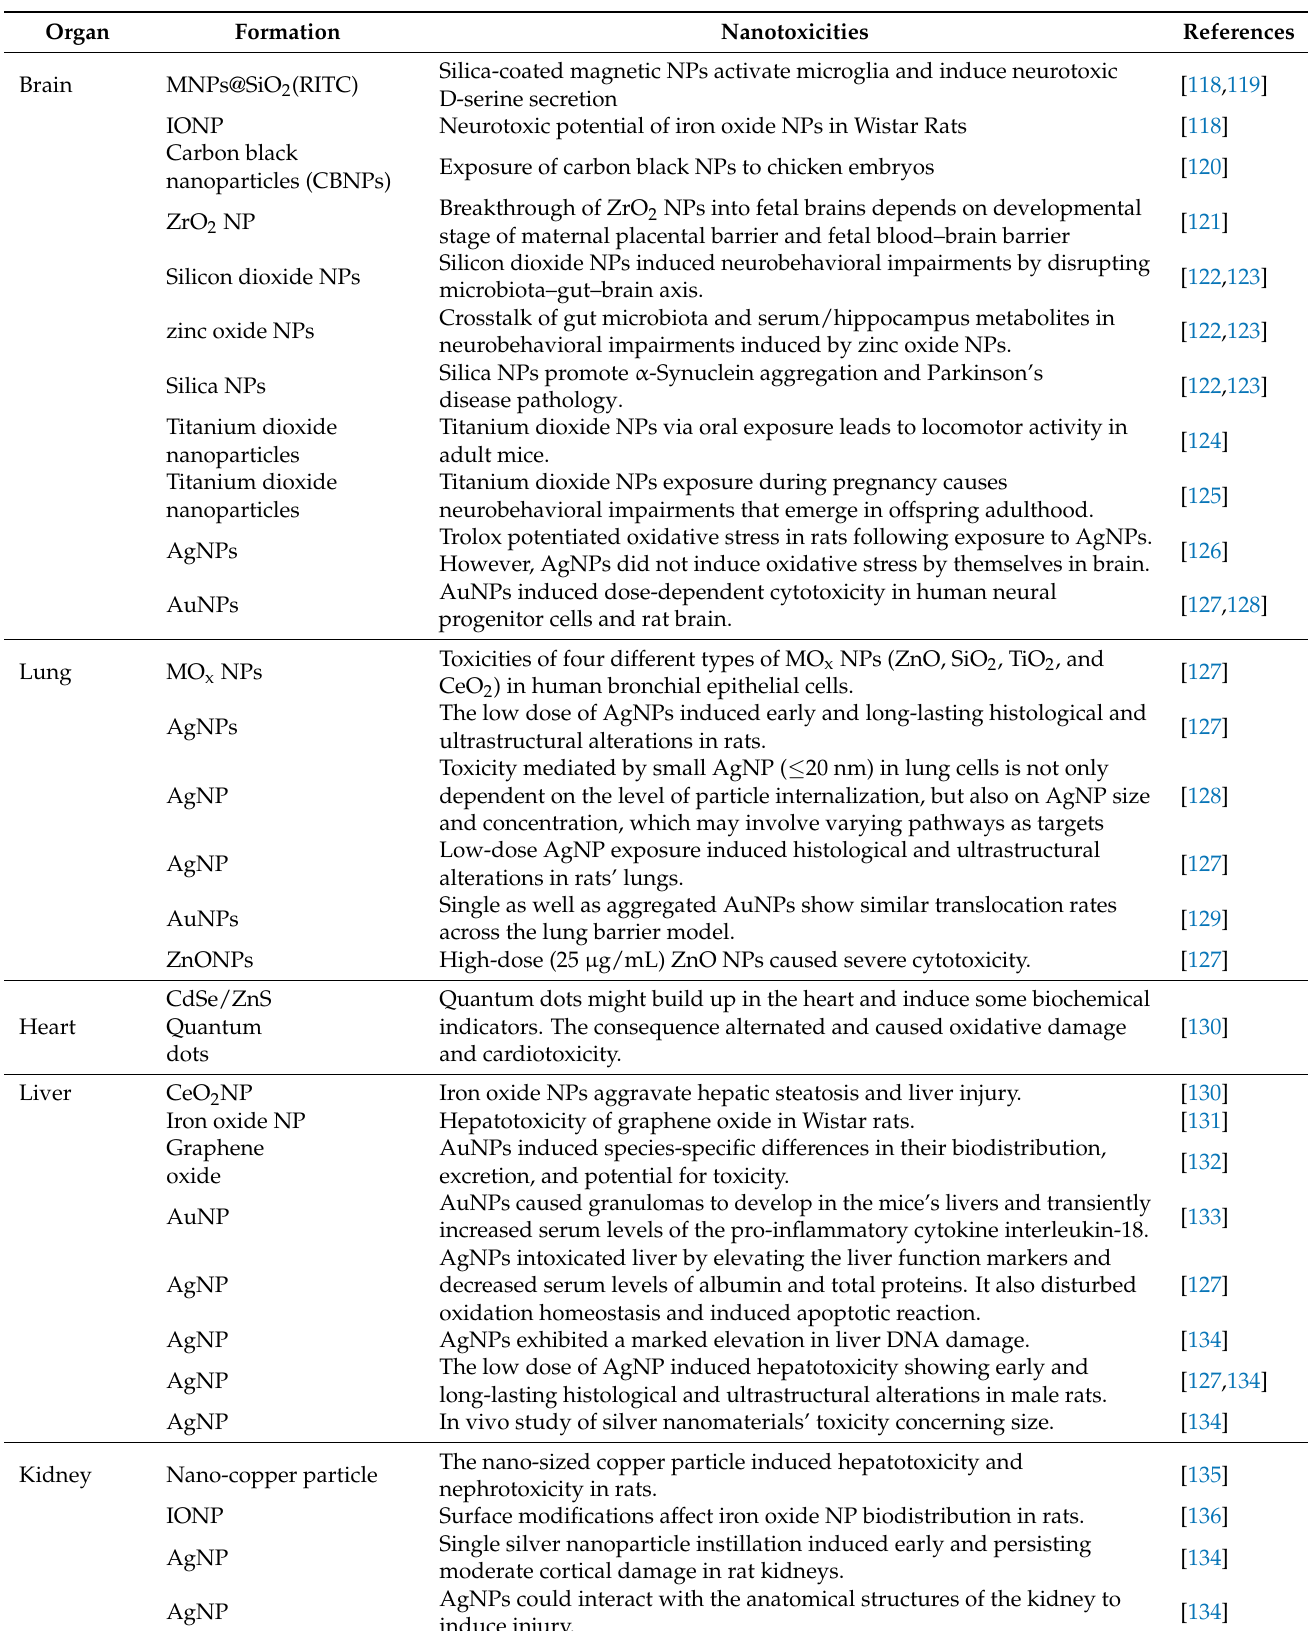
Table 2. Nanoparticle-induced toxicities in different